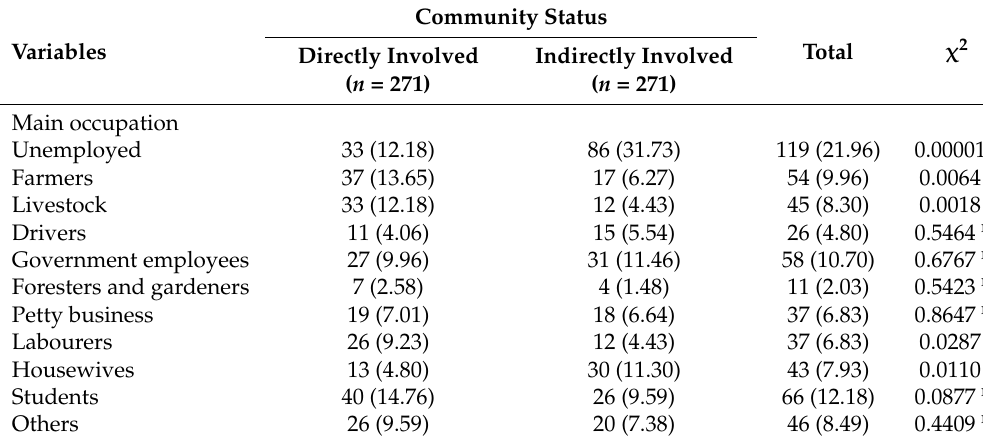
Table 7. Socio-economic activities of the respondents. Figures in parentheses are averages while those outside of parentheses are frequencies.